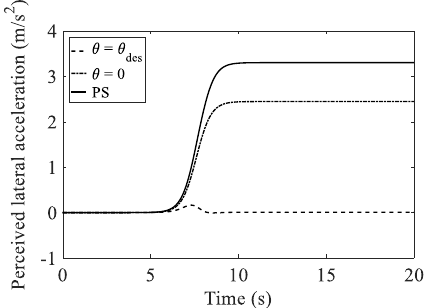
Figure 7. Perceived lateral acceleration.